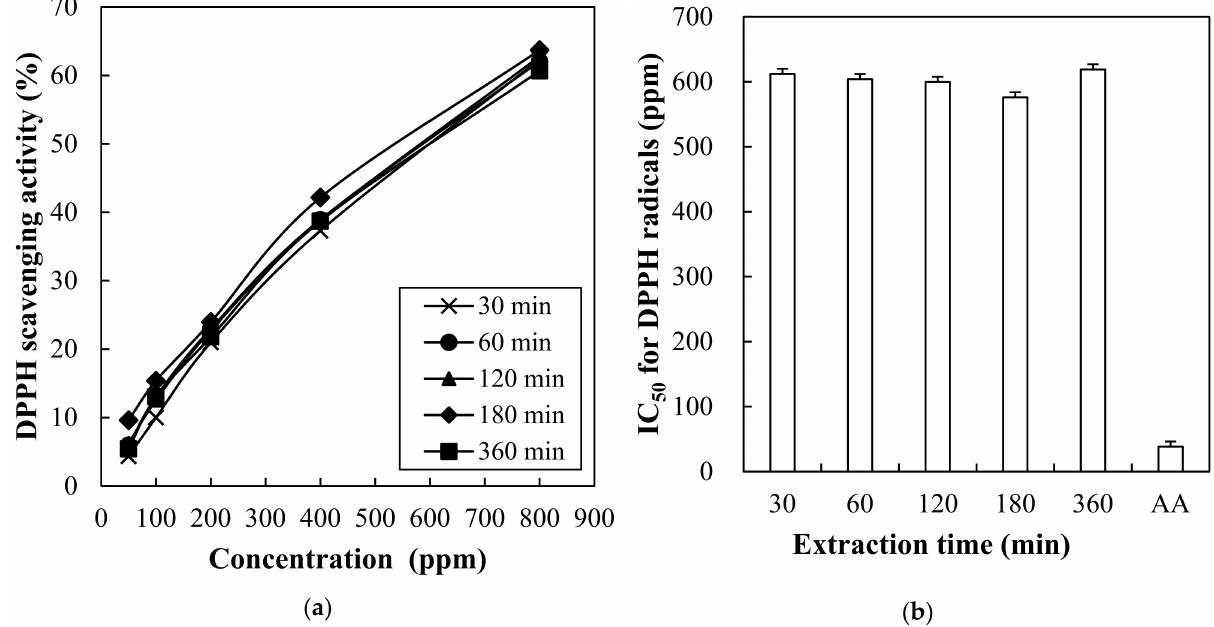
Figure 2. Change in DPPH radical scavenging activity at different concentrations ( a ) and IC 50 values for DPPH radicals ( b ) of red maple leaf extracts through hot water extraction (60 ◦ C) for 30, 60, 120, 180, and 360 min. AA, L-ascorbic acid (as control). Error bars represent standard error of the